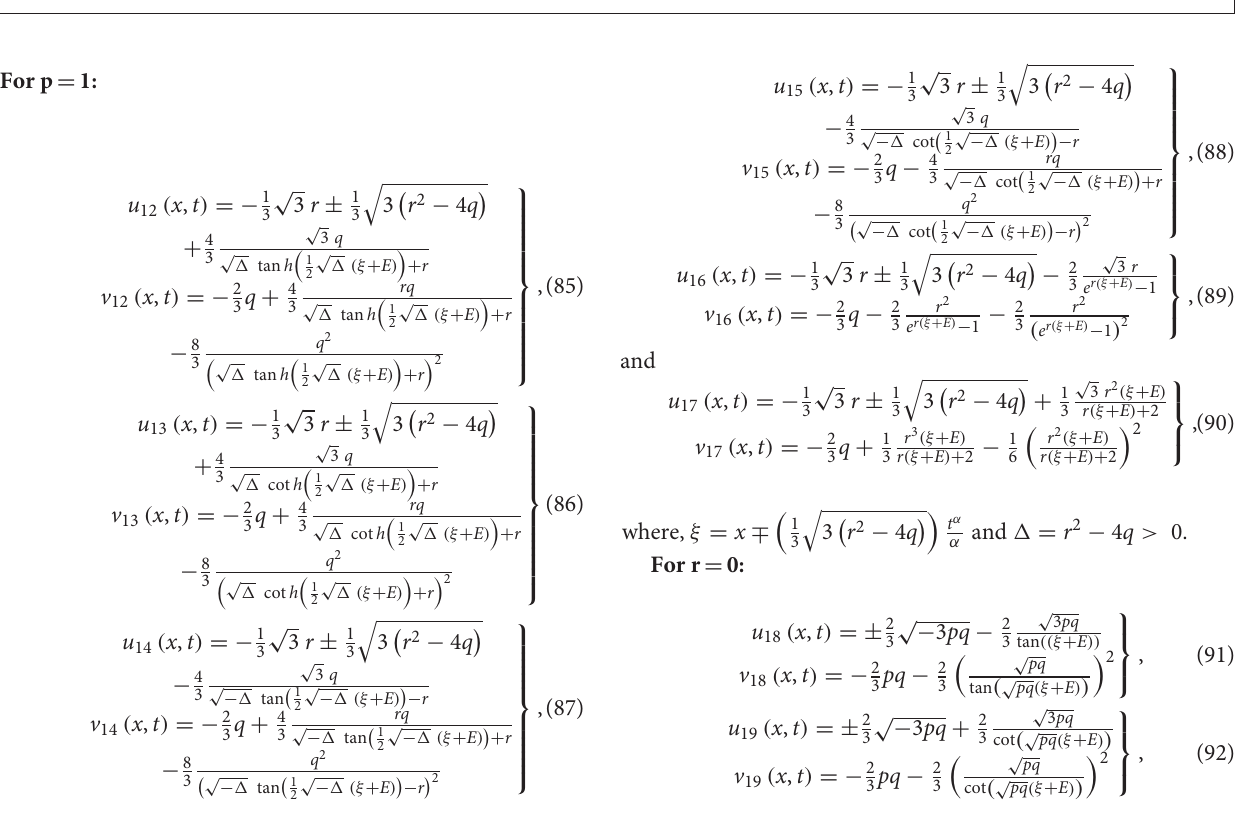
FIGURE 5 | (A–D) The Solution u_5 (x,t) given by Eq. (79).